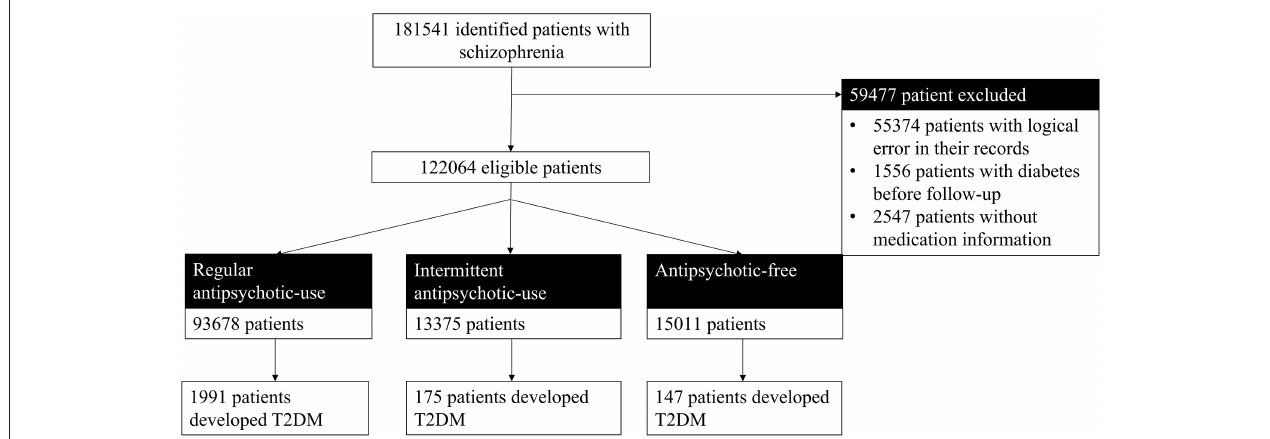
FIGURE 1 | Flowchart of the inclusion of participants. T2DM, type 2 diabetes